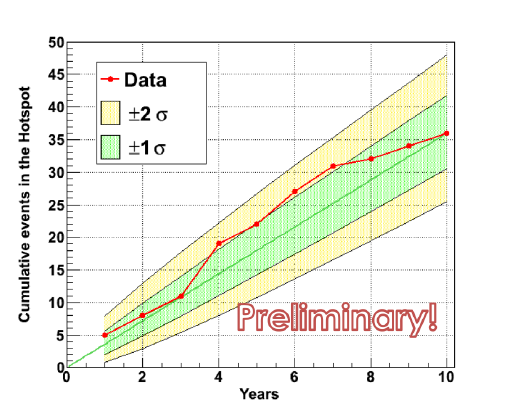
Figure 3. Integral time variation of the TA hotspot. Red points show the evolution of the data collection above 57 EeV within the hotspot region. Green and yellow shaded areas show 1 (cid:27) and 2 (cid:27) deviations from the rate of data observation respectively, as- suming a linear increase in